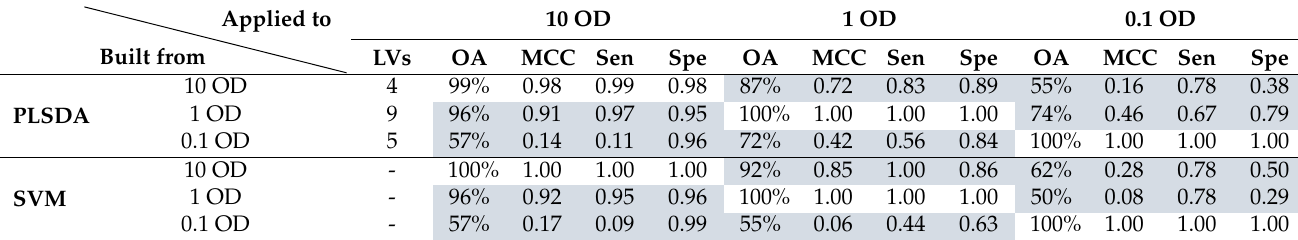
OA: overall accuracy; MCC: Matthews correlation coefficient; Sen: sensitivity; Spe: